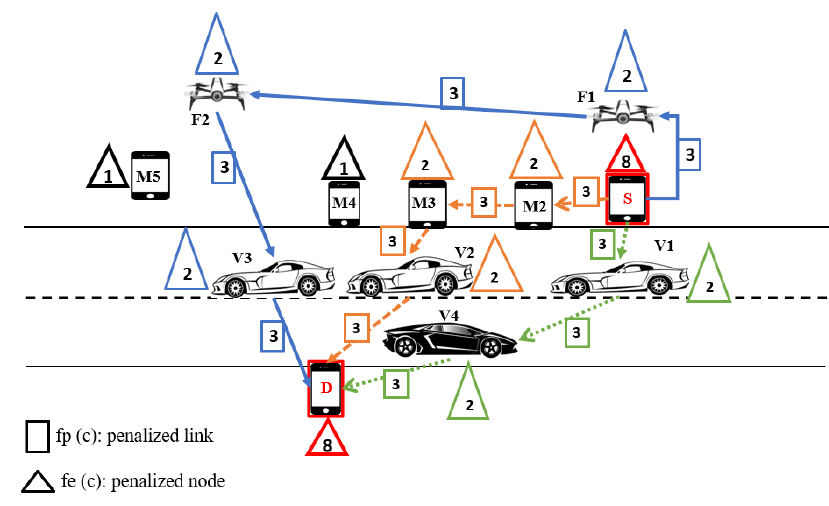
Figure 9. Example of MHAR-OLSR communication within an HAdN_MVF